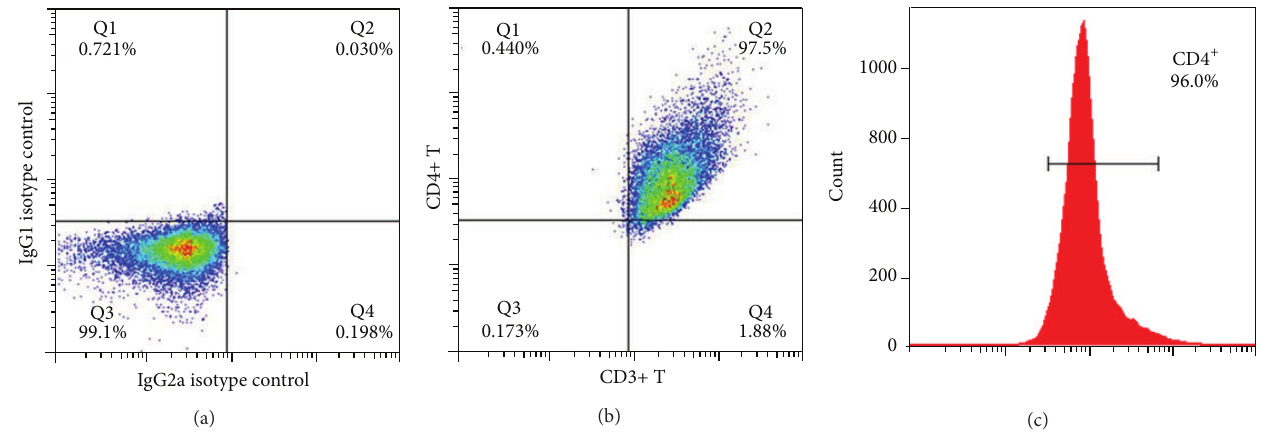
Figure 1: Purity verification of separated CD4 + T cells by flow cytometry. (a) showed the isotype control performed by Simultest IgG2a/IgG1. (b)represents double staining by anti-human CD3 and CD4 antibody. (c)represents anti-human antibody CD4staining. Theseresultsshowed that the purity of CD4 + from PBMC can reach a percent of more than 95%.